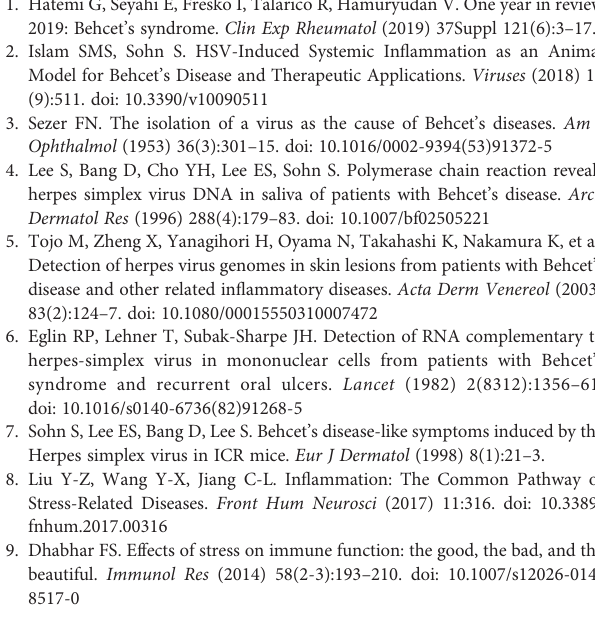
Supplementary Figure 3 | Frequencies of DC co-stimulatory molecules CD40, CD83, and CD80 in peripheral blood leukocytes (PBLs) of normal mice are elevated after inducing oxidation using xanthine sodium salt. Isolated PBLs were analyzed by fl owcytometryaftersurfacestaining (A – D) .Forstatistical analysis,one-wayANOVA was performed using GraphPad. Experiments were conducted independently at least three